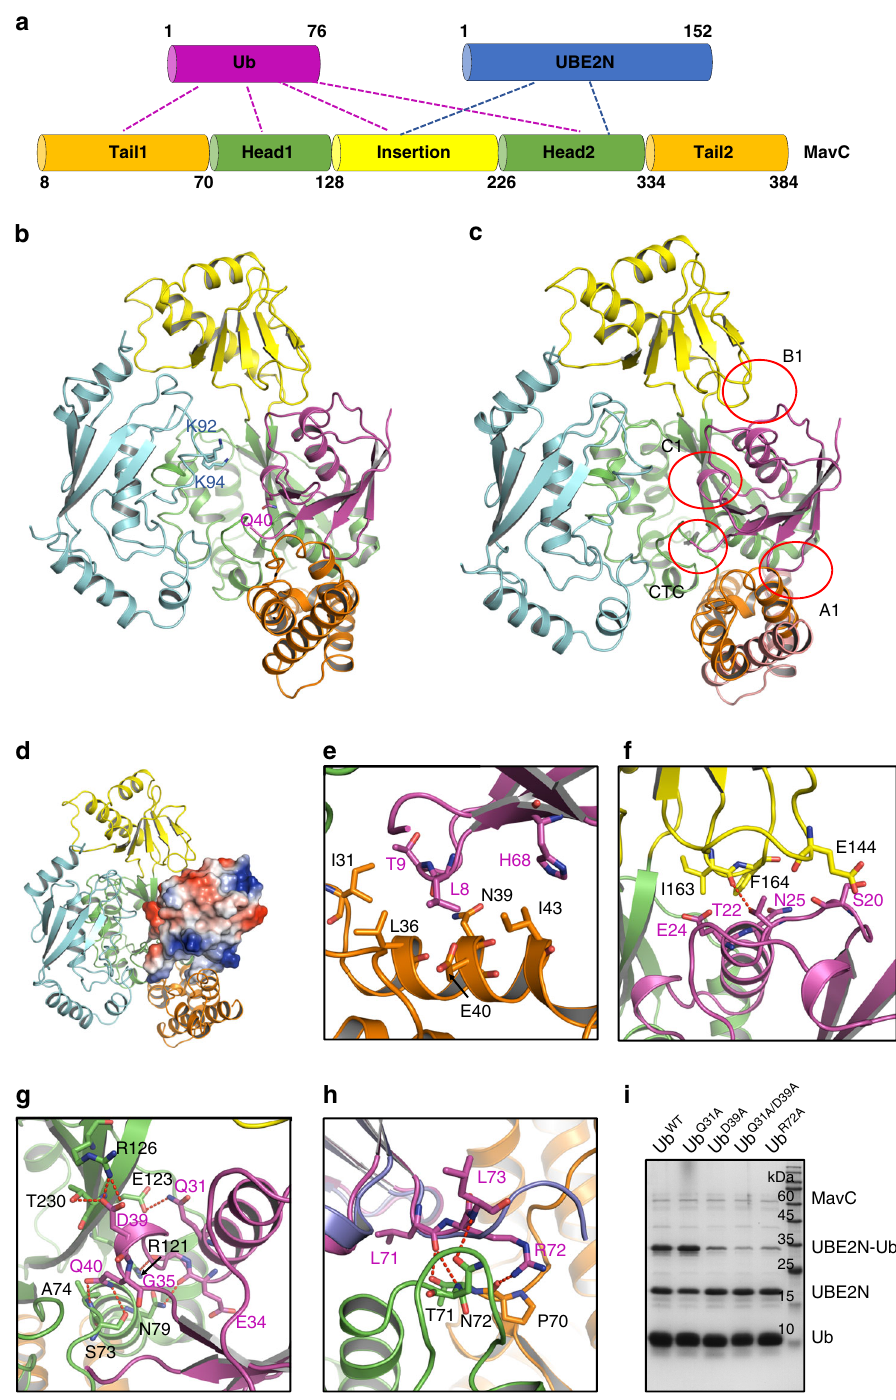
Fig. 1 Overall structure of the MavC/UBE2N/Ub complex. a Domain architecture of MavC showing interaction modes among MavC, UBE2N, and Ub. b Overall structure of the MavC/UBE2N/Ub complex, colored as in a . Q40 of Ub, K92 and K94 of UBE2N are shown as sticks. c Overview of the interfaces between MavC and Ub in the MavC/UBE2N/Ub complex. d Overall structure of the MavC/UBE2N/Ub complex, with Ub shown in the electrostatic surface model. e – g Detailed interfaces of MavC – Ub interaction as marked in c , including A1 e , B1 f and C1 g . Hydrogen bonds are represented as red dashed lines. h Detailed CTC interface of MavC – Ub interaction as marked in c . Ub in the CHBP/Ub structure is colored in blue, and aligned to that in the MavC/UBE2N/ Ub complex. i Mutations of the MavC-interacting residues in Ub decreased its ability in MavC-catalyzed ubiquitination. Ub and its mutants were incubated with MavC and UBE2N for 1 h at 37 °C. Then the samples were subjected to Tricine gel, followed by Coomassie blue staining. Source data are provided as a Source Data fi le. The experiment was repeated independently three times with similar